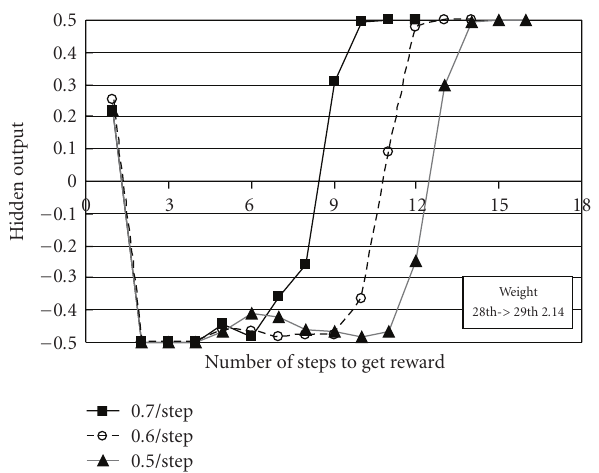
Figure 17: Output change of the 28th hidden neuron for the three velocities.